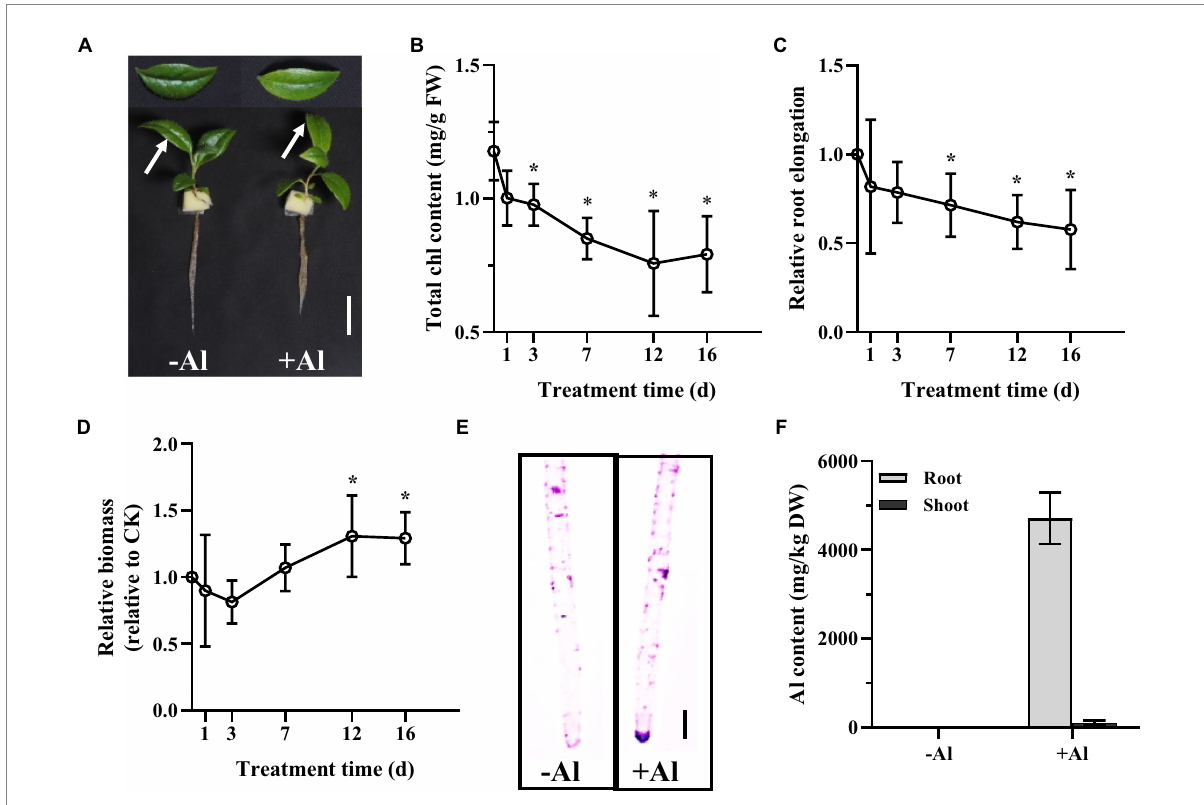
FIGURE 1 High Al tolerance in R. yunnanense Franch. Two-month-old seedlings were subjected to 1/5 nutrient Hoagland solution with or without 50 μ M Al for 16 days. (A) Photo shows phenotype of seedlings without ( − Al) or with (+Al) after 16 days. Bar = 1 cm. (B) Change of Chl content of newly expanded leaves during Al stress. (C) Relative root elongation. (D) Relative root biomass. (E) Hematoxylin staining of root apex after 7 days of Al treatment. (F) Al content in roots and shoots after 7 days of treatment. Asterisks (*) represent a significant difference in comparison with 0 μ M Al